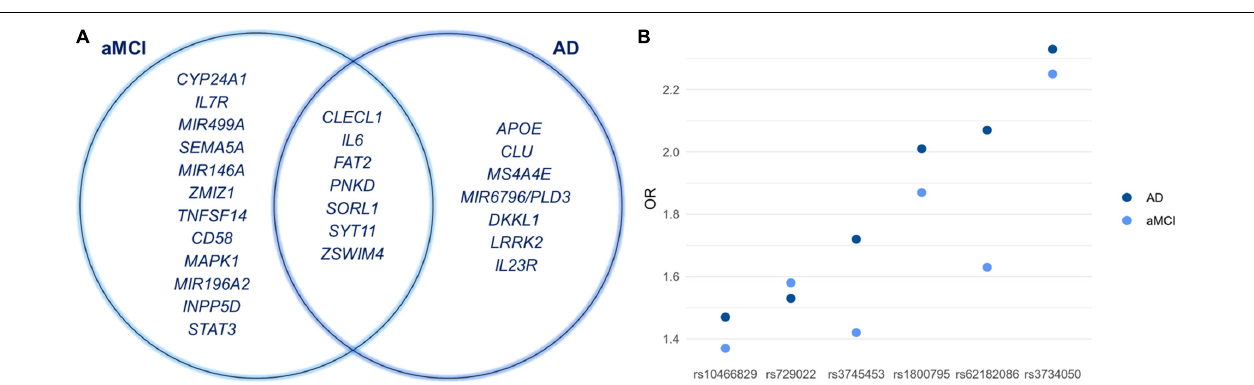
FIGURE 1 | (A) Venn diagram showing shared and specific genes associated with aMCI and sporadic AD conditions. (B) The graph illustrates the ORs of the shared variants that are slightly higher in AD patients with respect to aMCI group. Although the rs11218343 is shared between aMCI and AD, it cannot be included in the graph because the OR is not